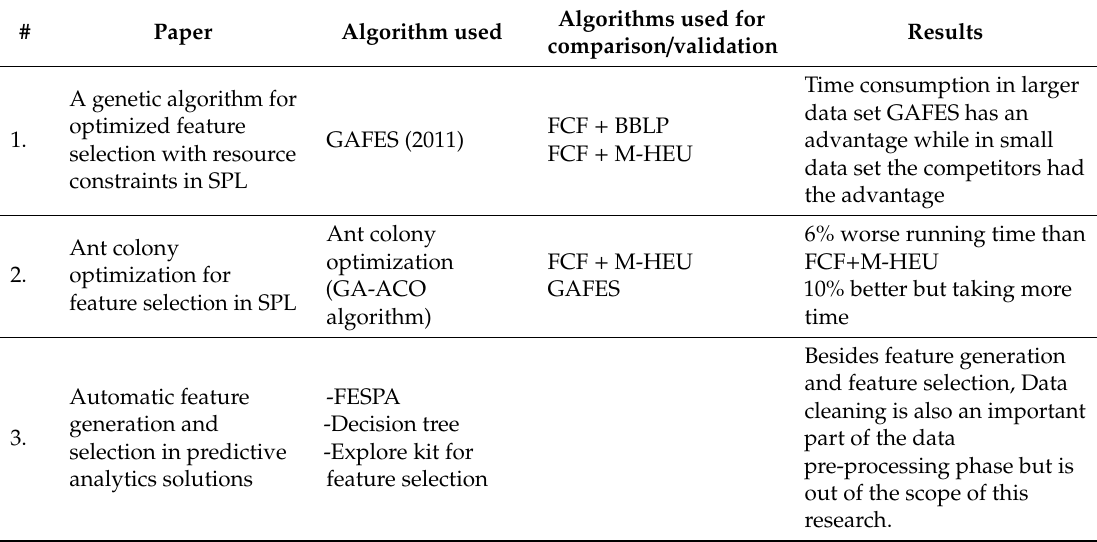
Table 1. Algorithms for feature selection. GAFES: Genetic Algorithm for FEature Selection; FCF: Filtered Cartesian Flattering; BBLP: Branch and Bound with Linear Programming; M-HEU: Modified